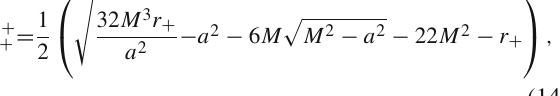
Fig. 1 Left panel: frequencies ω ± for fixed values of the spin a / M for BHs and NSs . The coalescence of the Killing horizons r + and r − in the extreme black hole geometries and the emergence of a Killing throat and a Killing bottleneck in the NS geometries are clear – see also